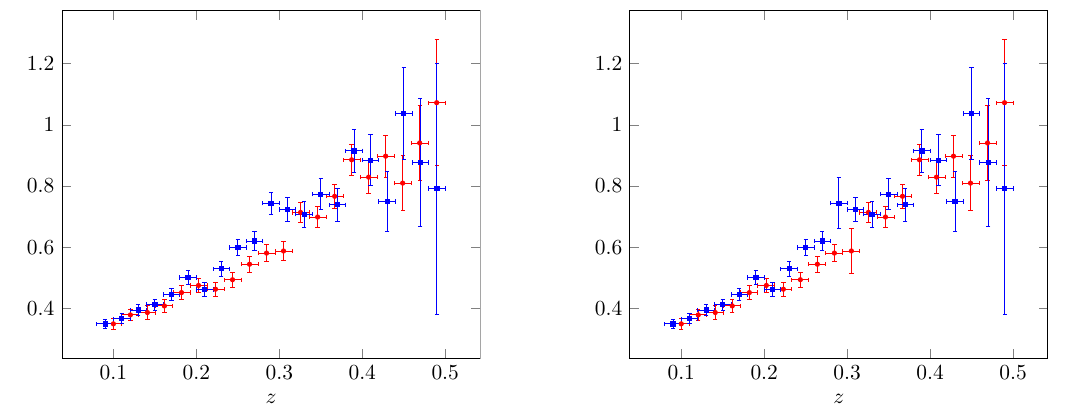
2 , in units of 10 (cid:0) 11 , in the electron mode W + ( z ) j j